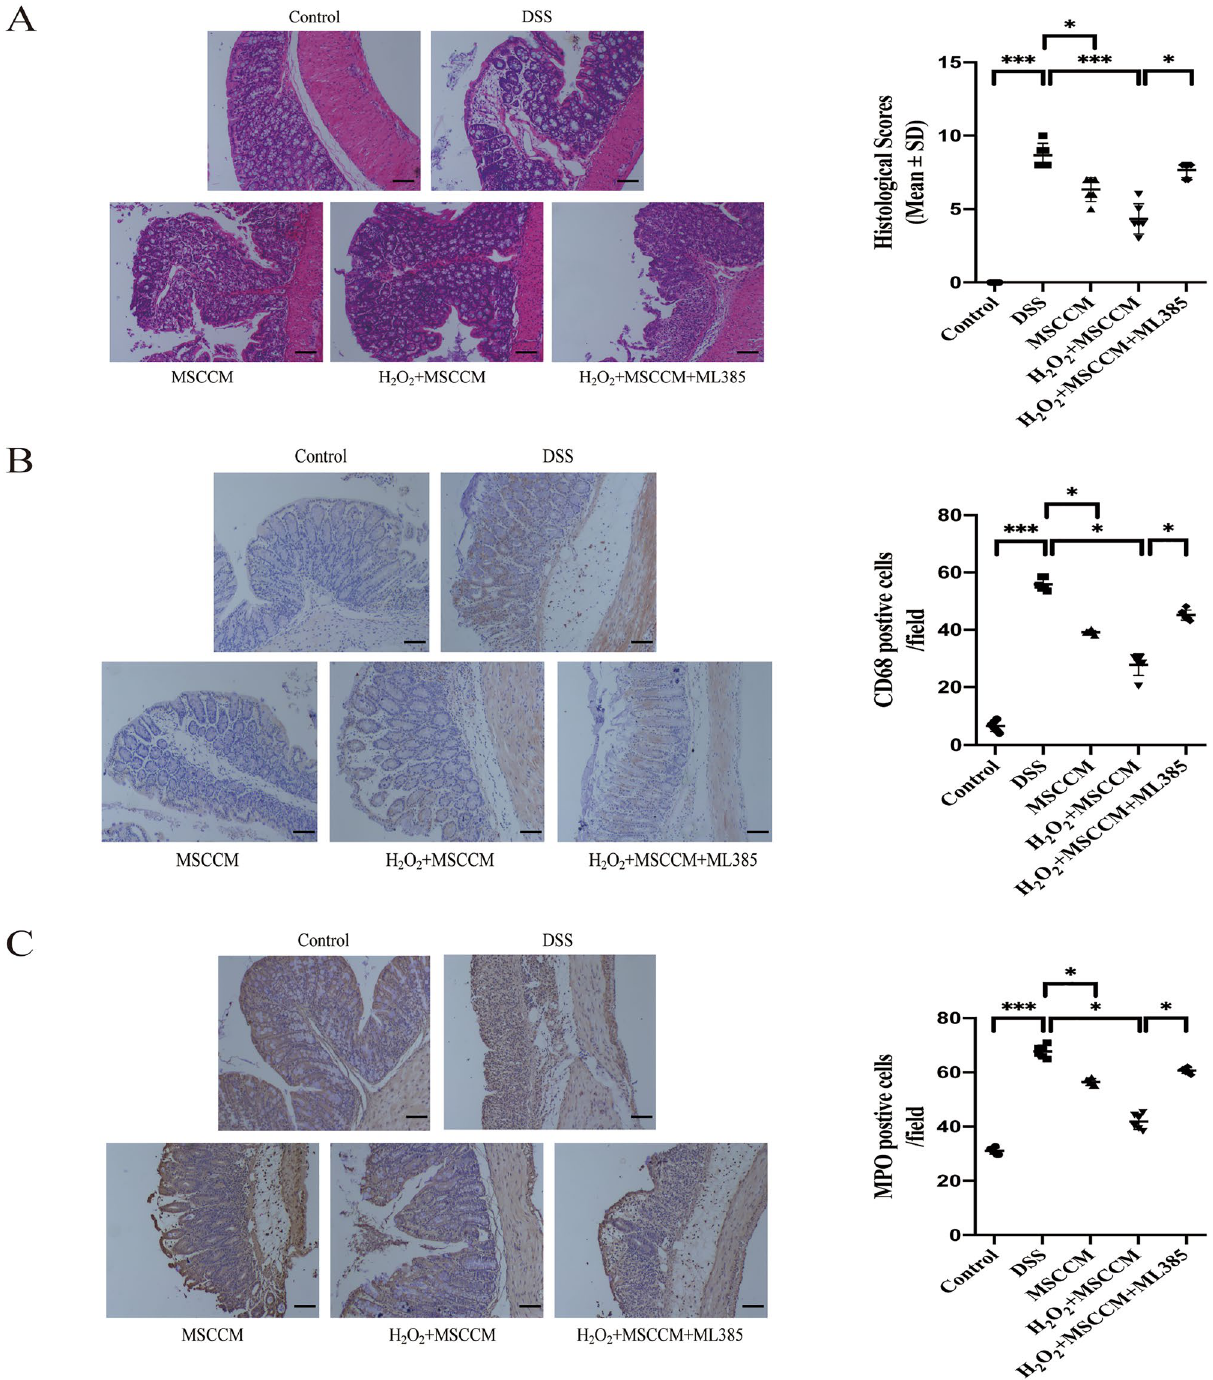
Figure 4. H 2 O 2 pretreated MSC-CM decreases the inflammatory cell in colon tissue. ( A ) Distal colons were removed and sectioned followed by H&E staining. Representative sections are displayed. Inflammation scores were evaluated in bar graph. ( B ) IHC analysis for the macrophage specific marker CD68 was performed, and subsequently positive cells were evaluated. Magnification: × 100. Scale bar, 100 μm. ( C ) IHC analysis for the neutrophil specific marker MPO was performed, and subsequently positive cells were evaluated. The insets are magnified images of the indicated rectangles. Magnification: × 100. Scale bar, 100 μm. Data are expressed as the mean ± SD. n = 6 animals per group per time point. * P < 0.05, ** P < 0.01, and *** P < 0.001; ns no